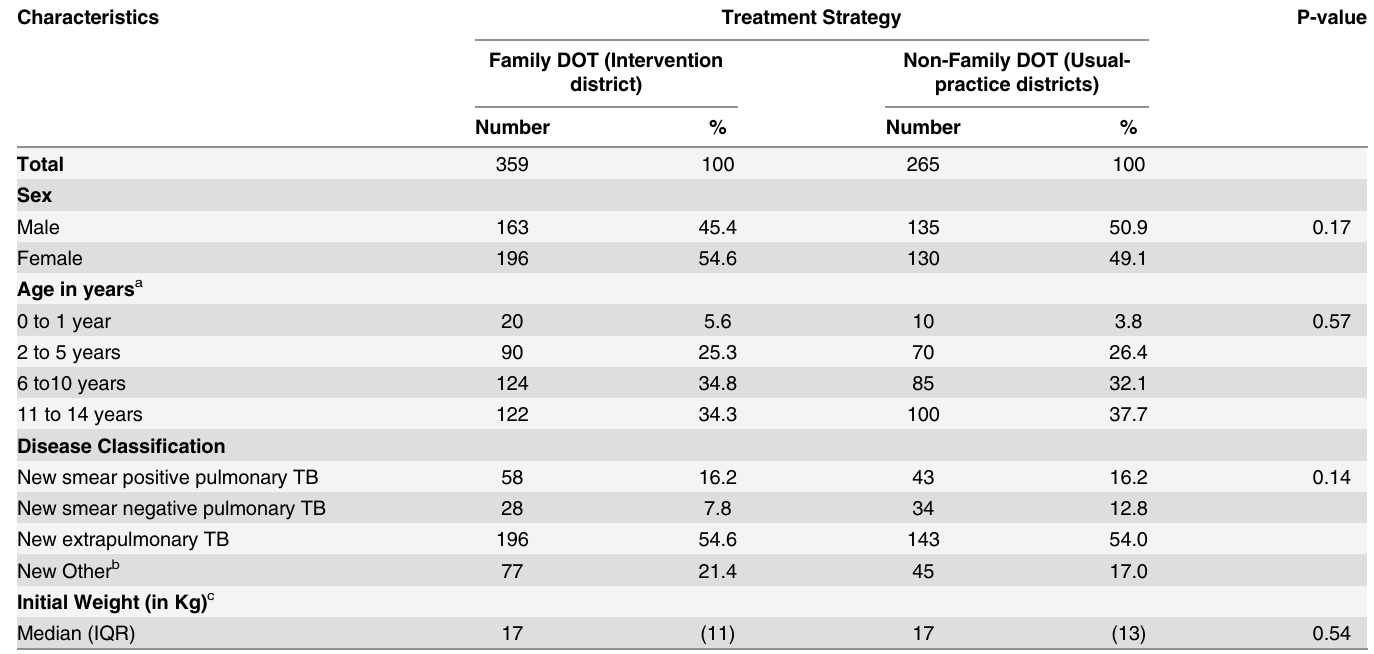
Table 2. Comparison of baseline characteristics among children with newly diagnosed TB, by treatment strategy, registered in Gujarat State, India, June-September 2012.